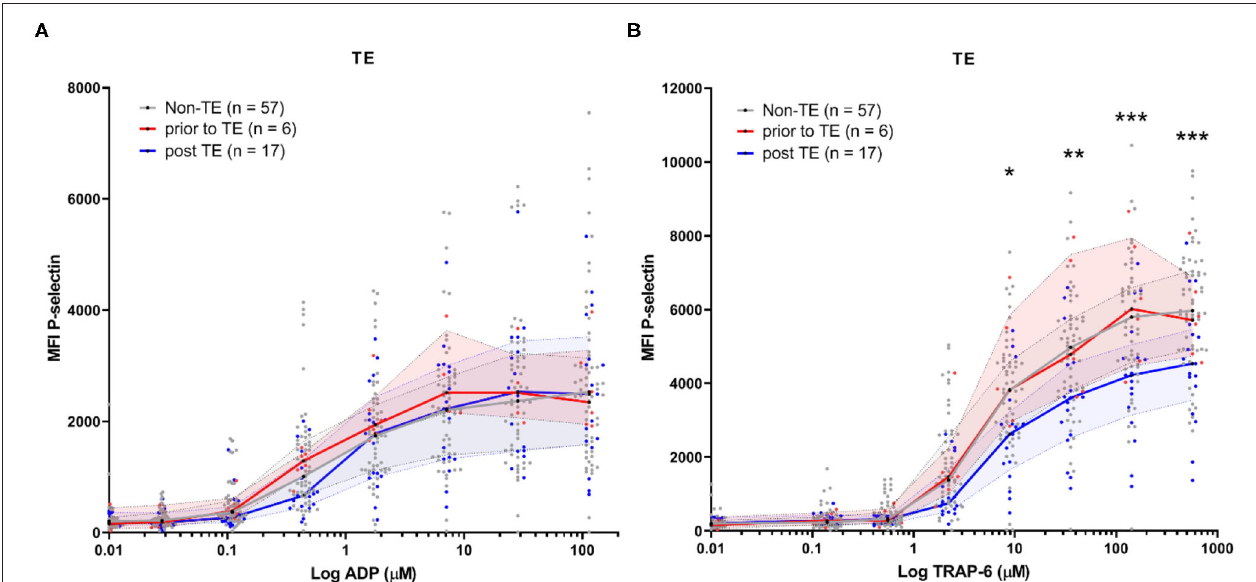
FIGURE 4 | COVID-19 patient platelet reactivity of patients that develop (a) thrombotic event(s) (TE) stratified prior or after the occurrence of the TE. Median fluorescence intensity (MFI) of platelet P-selectin expression in response to ADP (A) , or TRAP-6 (B) . Data points represent individual values of platelet reactivity of patients prior to the occurrence of a TE ( n = 6; displayed in red), or after the TE ( n = 17; displayed in blue). For one patient platelet reactivity was measured both prior to and after experiencing TE. Both datapoints are included. For reference, platelet reactivity of patients that do not develop a TE ( n = 57) is displayed in gray. The median value and interquartile range are indicated. Statistical difference was tested using one-way ANOVA with preselected multiple comparisons (comparing platelet reactivity of post TE to non-TE) using Sidak’s multiple comparisons test. * p < 0.05; ** p < 0.005; *** p <